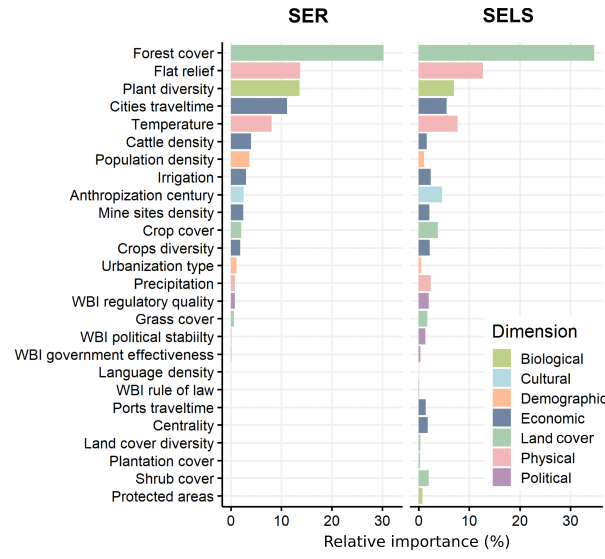
Fig. 2 . Relative importance plots for the social-ecological regions (SER; left) and social-ecological land systems (SELS; right). The values indicate the percent variable’s contribution to each of the two classification models generated through independent boosted regression trees. The colors of the bars indicate to which dimension the variables belong. Note: WBI = World Bank